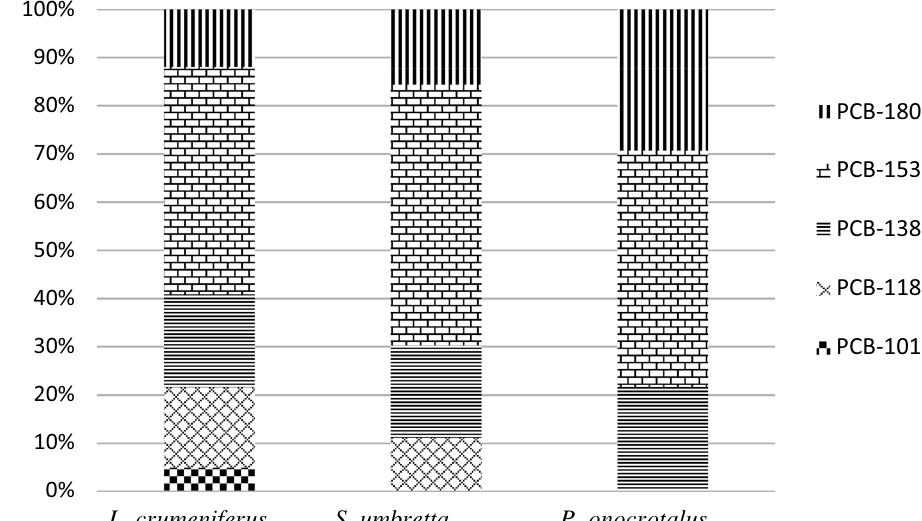
Fig. 2 The relative concentra- tion of PCB congeners in three species of